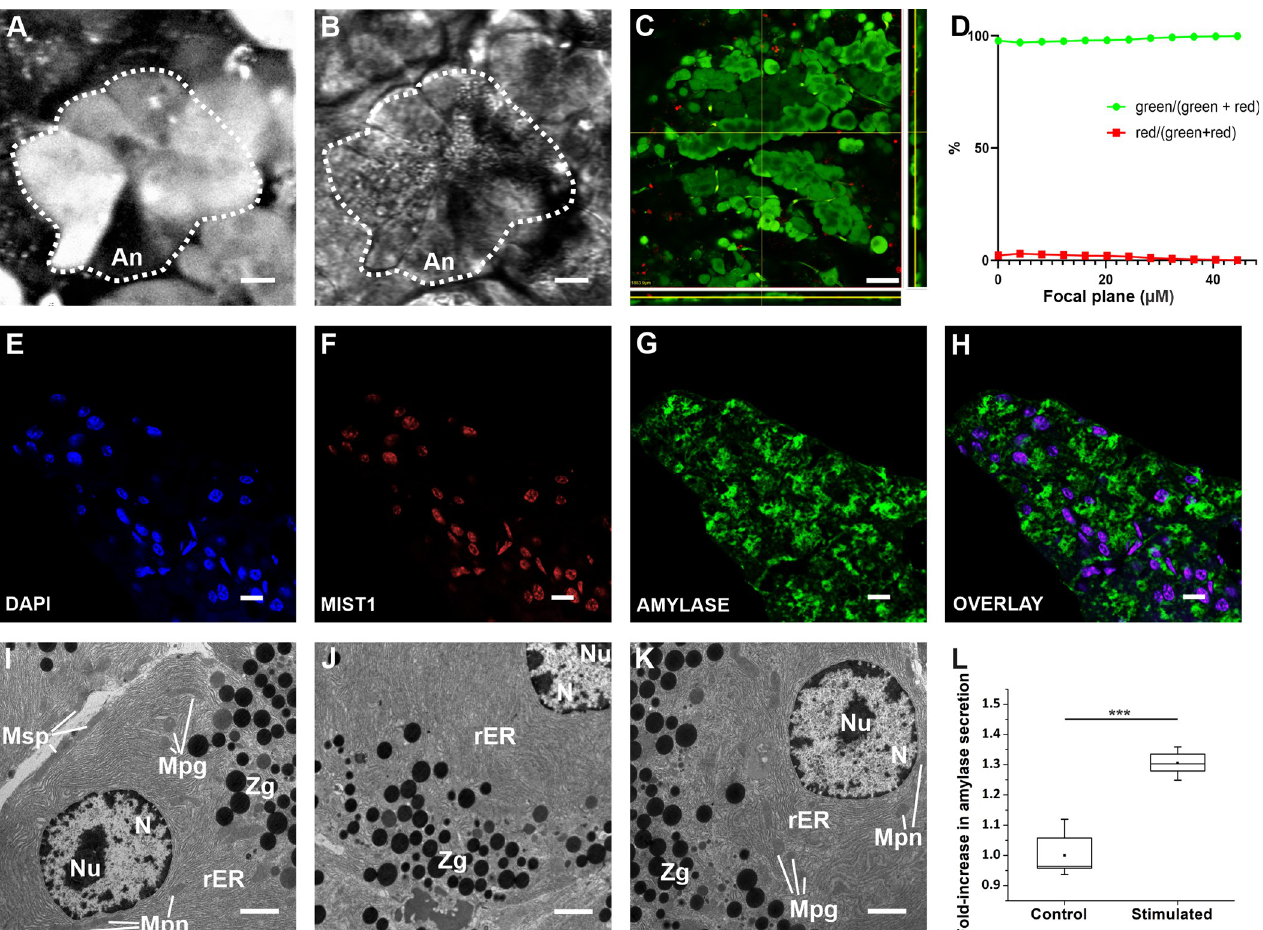
Fig 2. Morphology of acinar cells in mouse pancreas tissue slices. (A, B) High resolution confocal fluorescence images of the exocrine part of the pancreas, labeled with OGB-1 (A) and imaged with Dodt contrast (B). An; acinus is encircled by the broken line. Scale bar 10 μ m. (C) A layer from a z-stack, cells were loaded with the Live/Dead dye. Side panels represent orthogonal projections of the z-stack, positioned as indicated by yellow lines. Pseudo color-coded, such that green indicates live cells and red indicates dead cells. Scale bar 50 μ m. (D) The percentage of live cells in green and dead cells in red, as a function of depth of the focal plane within the slice. (E, F, G, H) Staining of nuclei with DAPI (E) and anti-Mist1 antibodies (F), and of cytoplasm with anti-amylase antibodies (G), with the overlay (H). Scale bar 10 μ m. (I-K) TEM images of acinar cells from a tissue slice. Mpn, perinuclear mitochondria; Mpg, perigranular mitochondria; Msp, subplasmalemmal mitochondria; Zg, zymogen granules; N, nucleus; Nu, nucleolus; rER, rough endoplasmic reticulum. Scale bar 10 μ m. (L) Quantification of amylase secretion upon stimulation by 0.1 nM cerulein, n = 6. Significant difference is indicted by asterisks ( ��� , p <